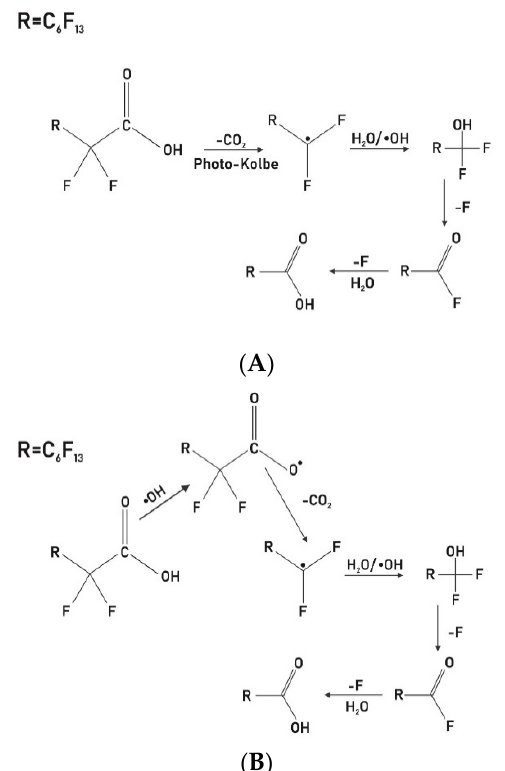
Figure 8. Possible pathways for the degradation of PFOA after ( A ) UV photocatalysis and ( B ) liquid aerobic oxidation [66].